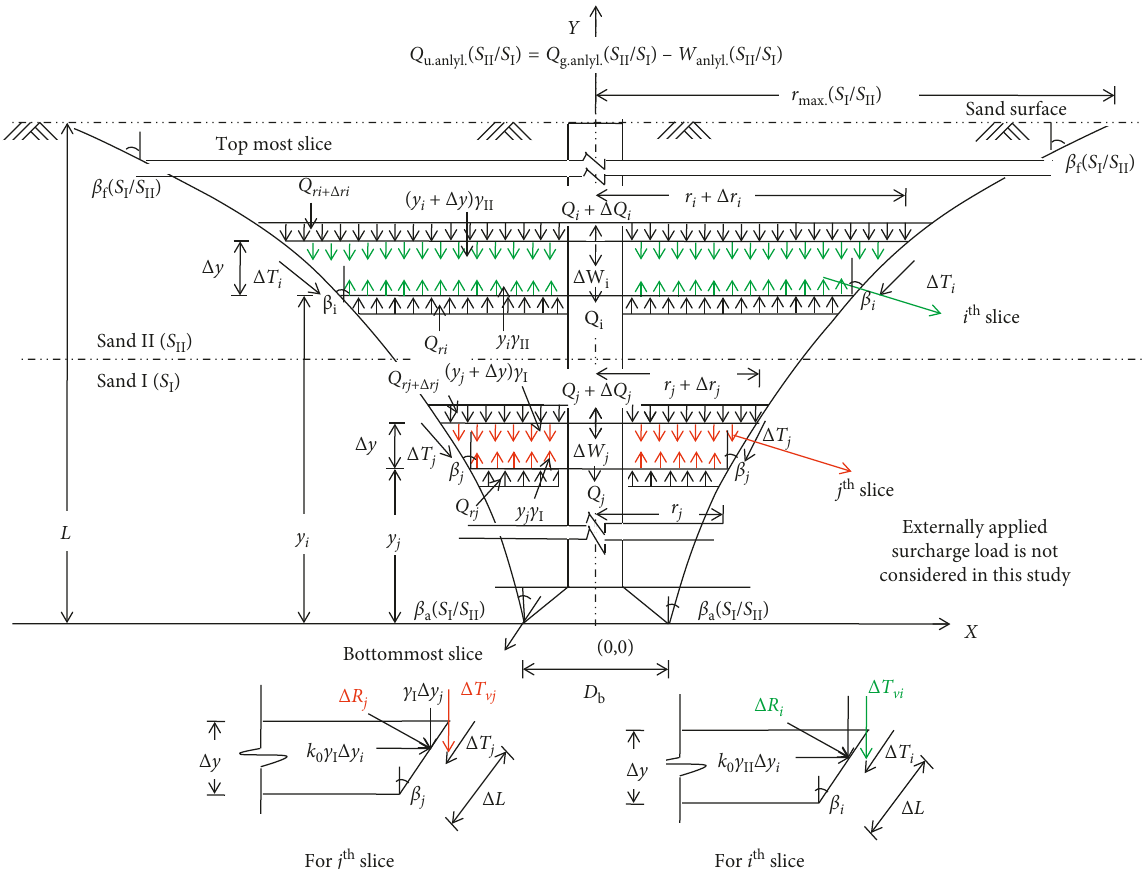
Figure 15: Free body diagram of a three-dimensional elemental slice wedge as per the horizontal slice method, in layered sand deposit ( S S I